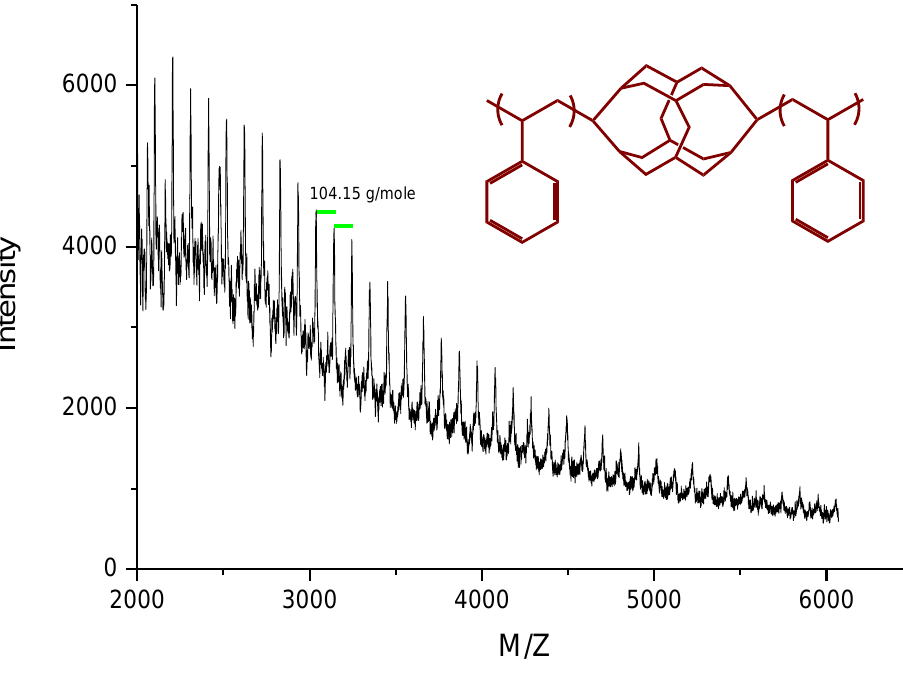
Figure 4. MALDI-TOF mass spectra of the hybrid polymer PS 20 -DDSQ-PS 20 .